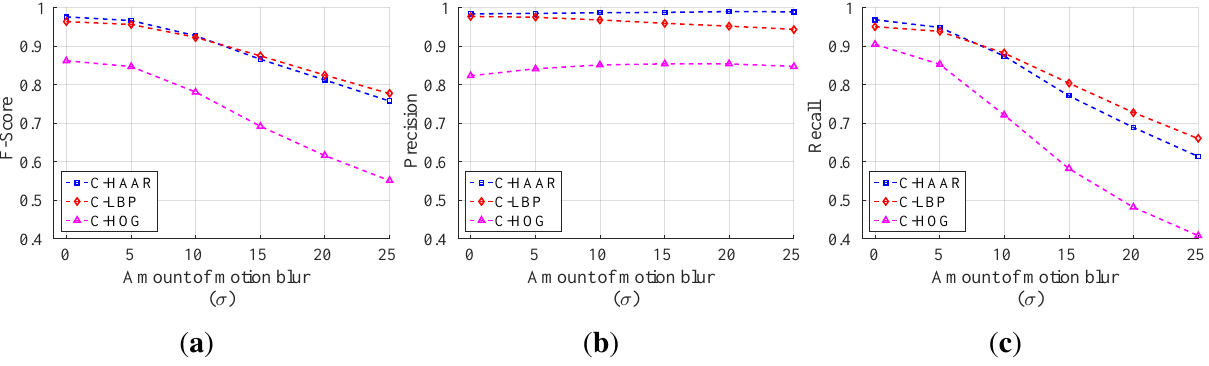
Figure 15. Performance of methods under motion blur. ( a ) F-score; ( b ) precision; and ( c ) recall. σ = 0 corresponds to original videos without motion